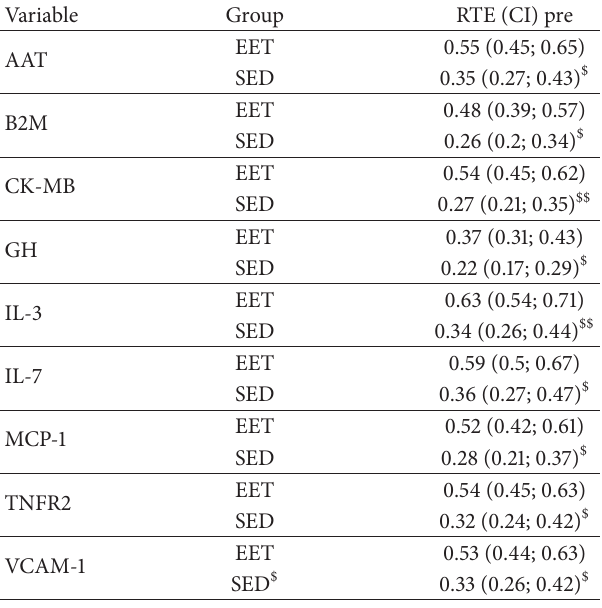
Table 4: Plasma variables of Tables 3(c) and 3(d) with significant differences between EET and SED individuals at baseline (pre). Displayed are the relative treatment effects (RTEs) and their corre- sponding 95% confidence intervals (CI). $ 𝑝 < 0.05 and $$ 𝑝 < 0.01 indicate significant differences between groups. EET: endurance- exercise-trained; SED: untrained/sedentary. Variable